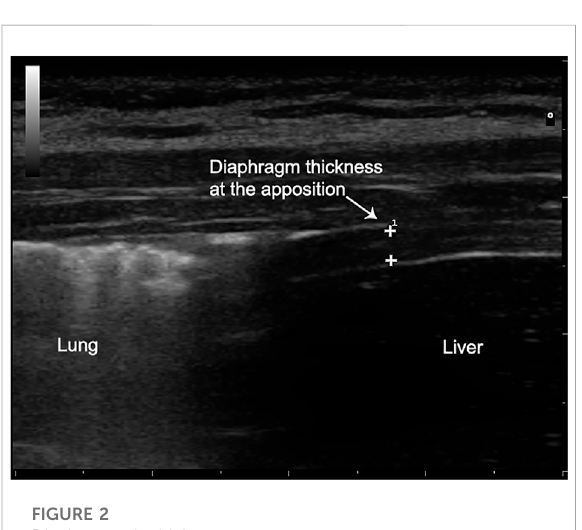
FIGURE 2 Diaphragmatic thickness